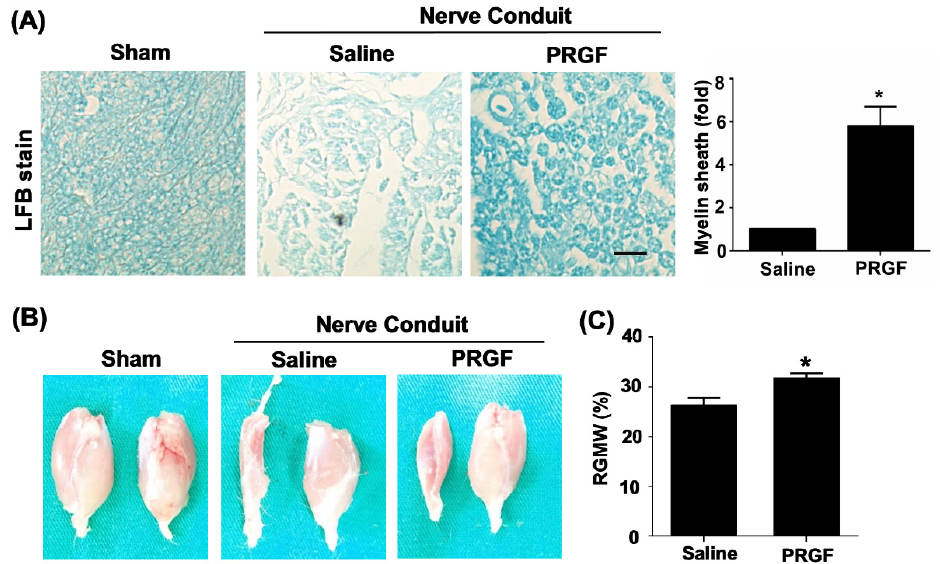
Figure 5. Myelin sheath formation and target muscle innervation confirmed the regenerative out- comes at 6 weeks post-sciatic nerve injury. ( A ) Luxol fast blue (LFB) staining showed an increase in myelin sheath formation for the nerve sections that received PRGF treatment as compared to the saline group. ( B ) The morphology of sciatic nerve innervated target gastrocnemius muscle on an injured (left) and normal (right) leg demonstrated the improvement of regenerated nerve to reinnervate the target muscle for preventing muscle atrophy. ( C ) The relative gastrocnemius muscle weight (RGMW) was quantified and showed an improvement in the PRGF-treated rats. Scale bar = 20 µm. N = 3. Significance was assessed by paired t -test. Data are presented as the mean ± SEM. * p < 0.05 versus to saline group.